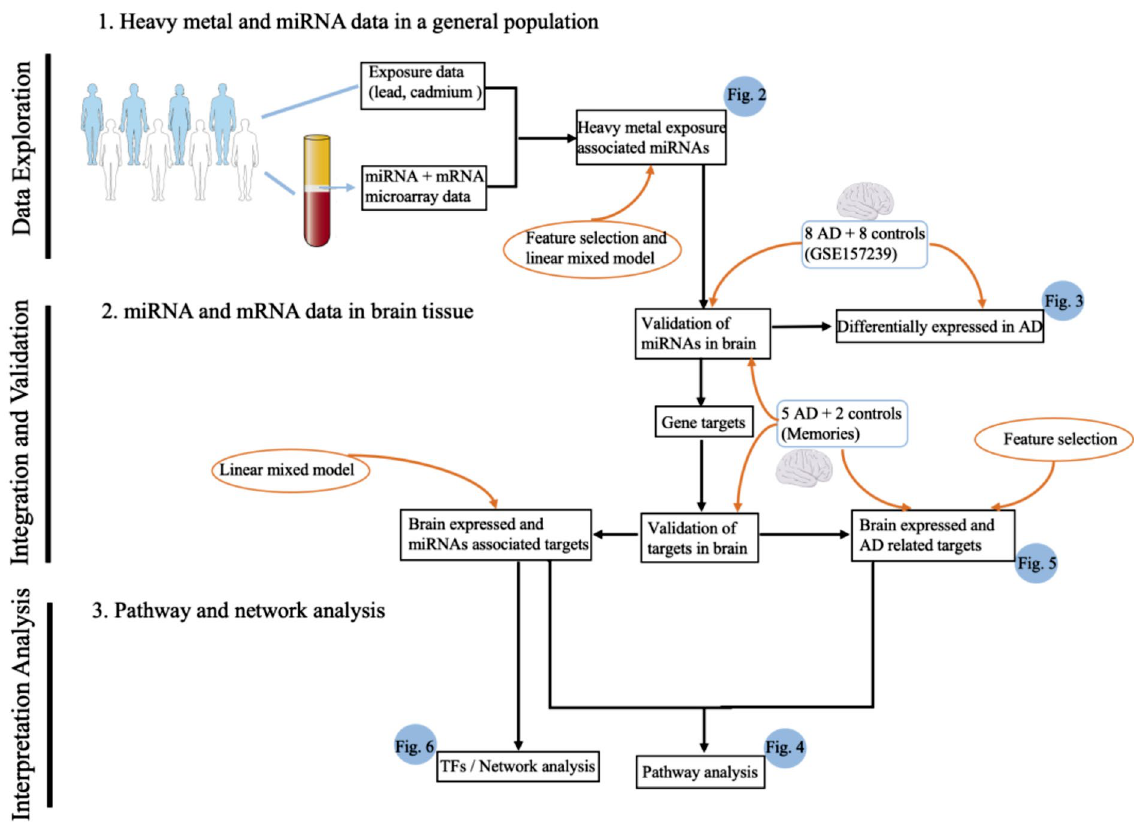
Figure 1. Workflow of the study. (1) We explored heavy metal (lead and cadmium) associated miRNAs in blood from a general population derived from the NSHDS by using feature selection and linear mixed model. (2) The resulting miRNAs were validated for expression in human brain by data from Memories, and publicly available dataset with larger sample size for different brain regions was used as additional validation and checked for differential expression. Subsequently, we derived experimentally validated gene targets for these miRNAs, which were also validated for expression in human brain (data derived from the Memories project). Next, we selected gene targets that showed an association with the identified miRNAs in transcriptomics data of NSHDS by using linear mixed model, and selected AD related gene targets based on the transcriptomics data of Memories project by using feature selection. (3) The identified gene targets were subjected to pathway analysis to elucidate molecular mechanisms of heavy metal-associated miRNAs. Moreover, we performed network analysis to interpret complex miRNAs-TFs-targets